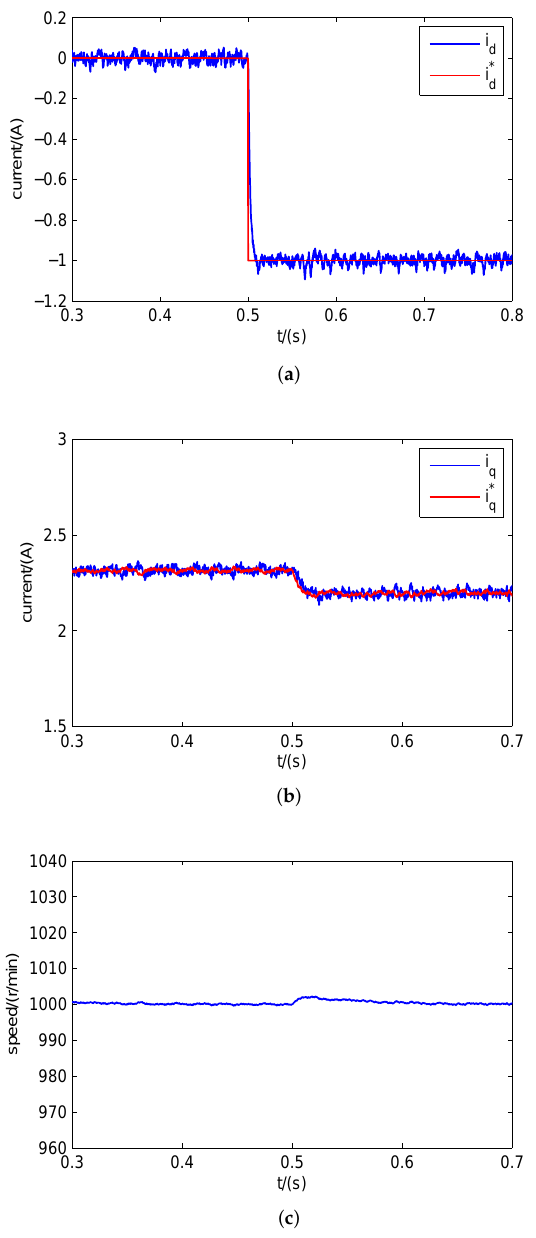
Figure 5. Simulation results with the proposed method when i ∗ current, and ( c ) speed